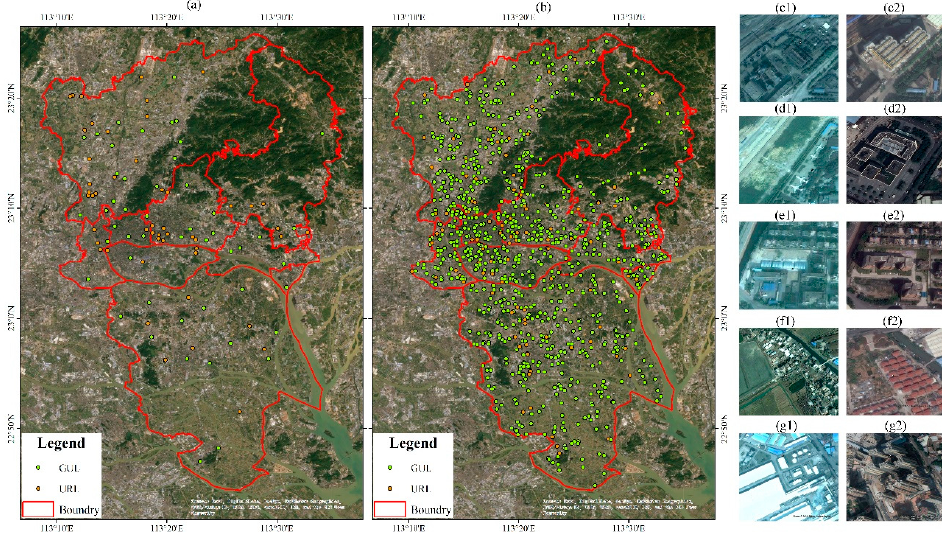
Figure 2. Random ground reference for algorithm training ( a ) and resultant accuracy assessment ( b ) of urban renewal land. ( c – g ) Very high spatial resolution images of urban renewal in the former and later phase from Google Earth. c (23.0589, 113.5125) is from an old factory (c1, 10 / 17 / 2007) and a new factory (c2, 12 / 5 / 2016); d (23.1772, 113.2638) shows a change from an airport (d1, 10 / 9 / 2007) to an o ffi ce